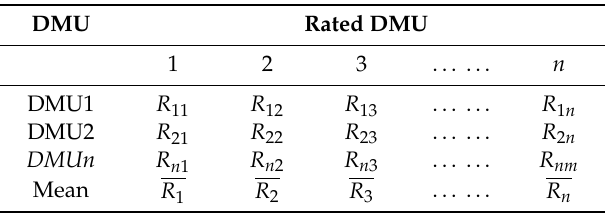
Table 2. A cross-e ffi cient risk matrix (CERM).